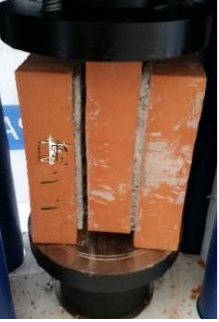
Figure 3. Experimental setup of masonry shear triplets.